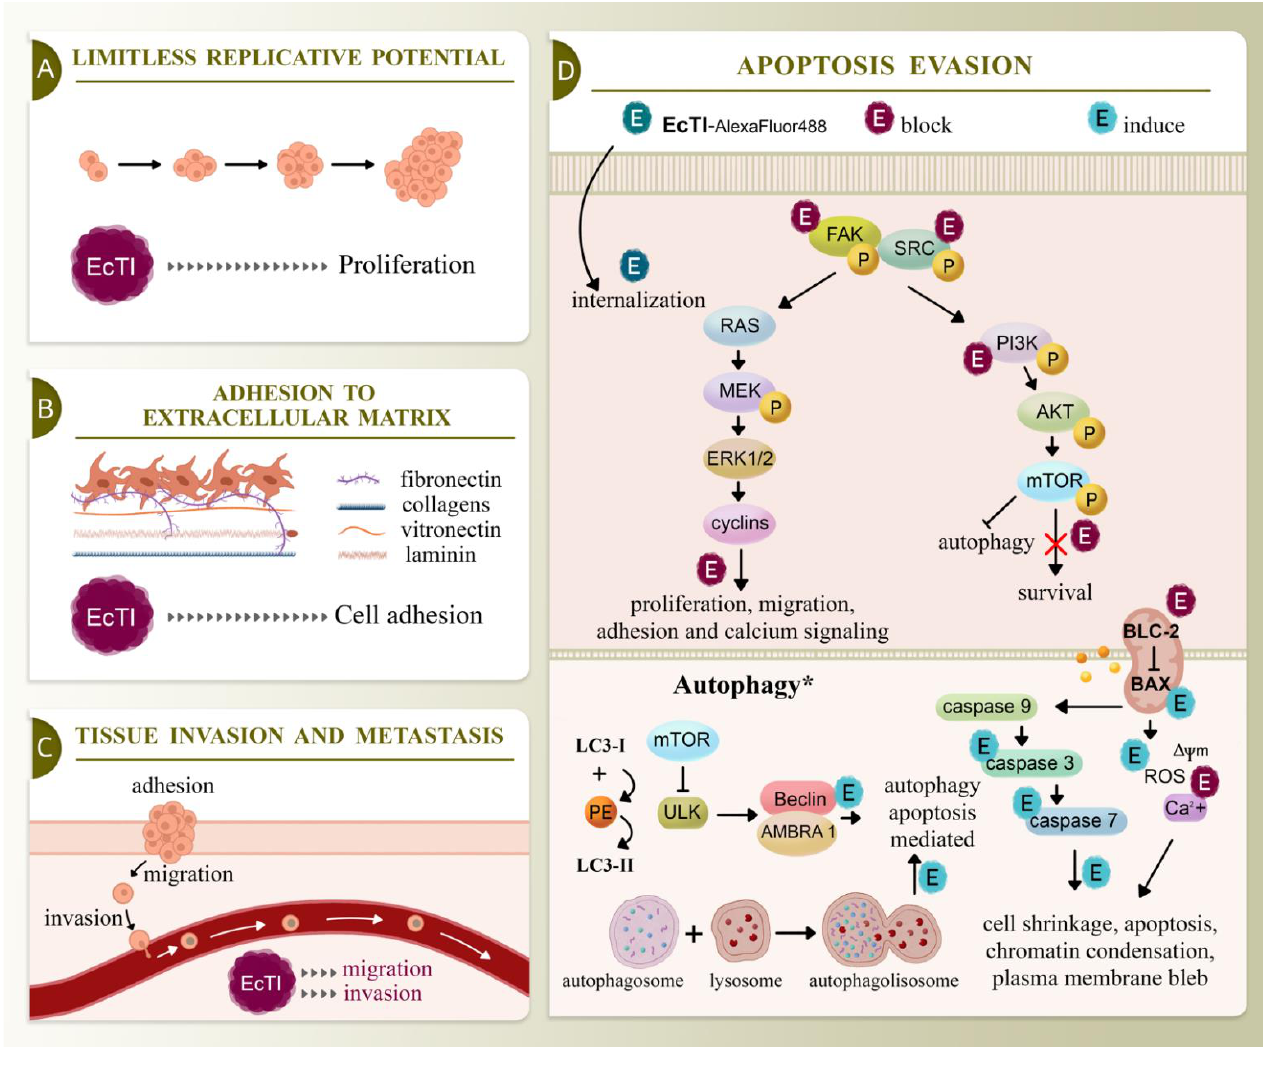
Figure 8. Signaling pathways of cancers include limitless replicative potential, adhesion to the extracellular matrix, tissue invasion and metastasis, and apoptosis evasion. ( A ) EcTI inhibits the replicative potential of melanoma cells, interfering with components of the extracellular matrix and reducing melanoma cell adhesion ( B ), which blocks melanoma migration, invasion, and metastasis ( C ). These events are mediated by the impairment in apoptosis evasion, interfering with proteins associated with proliferation, migration, adhesion, and calcium (Ca 2+ ) signaling and those associ- ated with the autophagy/apoptosis pathways, leading to cell shrinkage, chromatin condensation, plasma membrane blebbing, reactive oxygen species production (ROS), mitochondrial membrane potential disruption ( ∆ ψ m ), and apoptosis of melanoma cells ( D ). These findings together indicate the deleterious effect of EcTI on the SK-MEL-28 and CHL-1 cell lines by distinct